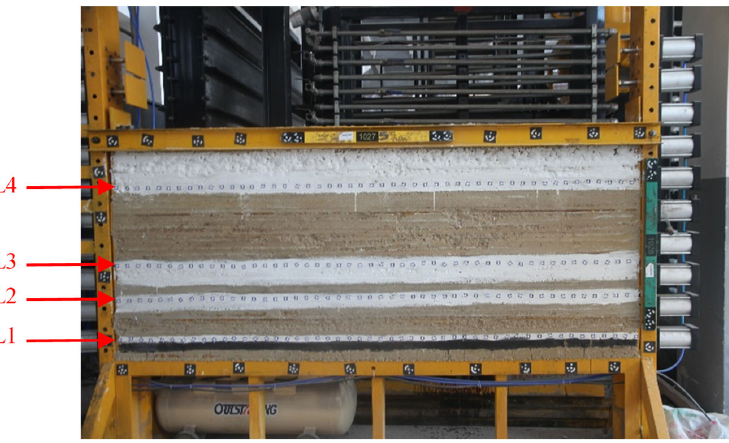
Figure 8. Mining and backfilling process in the physical model: ( a ) 2 cm mining height; ( b ) 4 cm mining height.